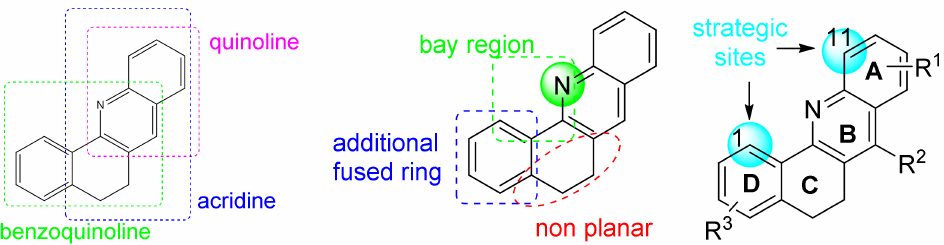
Figure 1. Molecular structure, characteristic structural features, and strategic site of 5,6-dihydrobenzo[ c ]acridine.